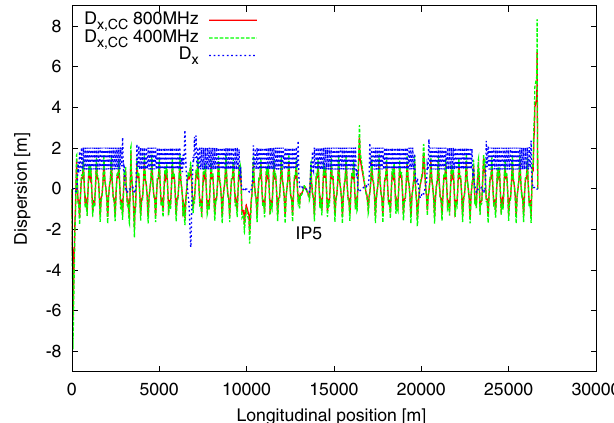
FIG. 22. (Color) z -dependent closed-orbit change induced by the global crab cavity in IR4. The maximum orbit change is about 1 (cid:3) .